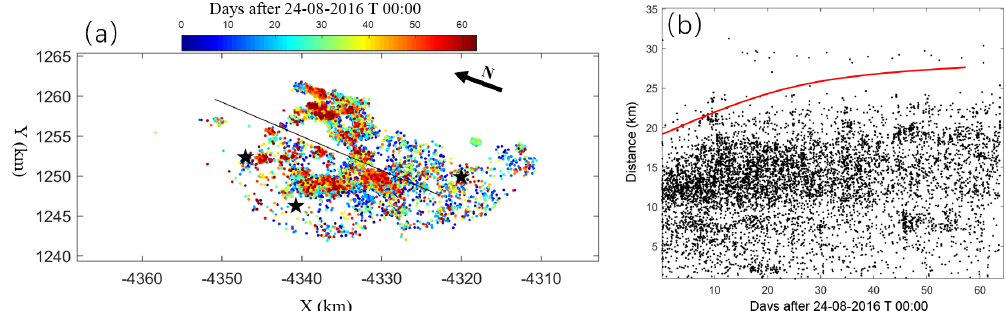
Figure 7. Observation of aftershock migration. (a) Aftershock on the projection plane colored by time. The arrow represents north. It is observed that most aftershock points in the north happened more recently than in the south, implying a northward migration trend. (b) Propagation distance as a function of time. The red line represents the temporal trend that the propagation distances increase with